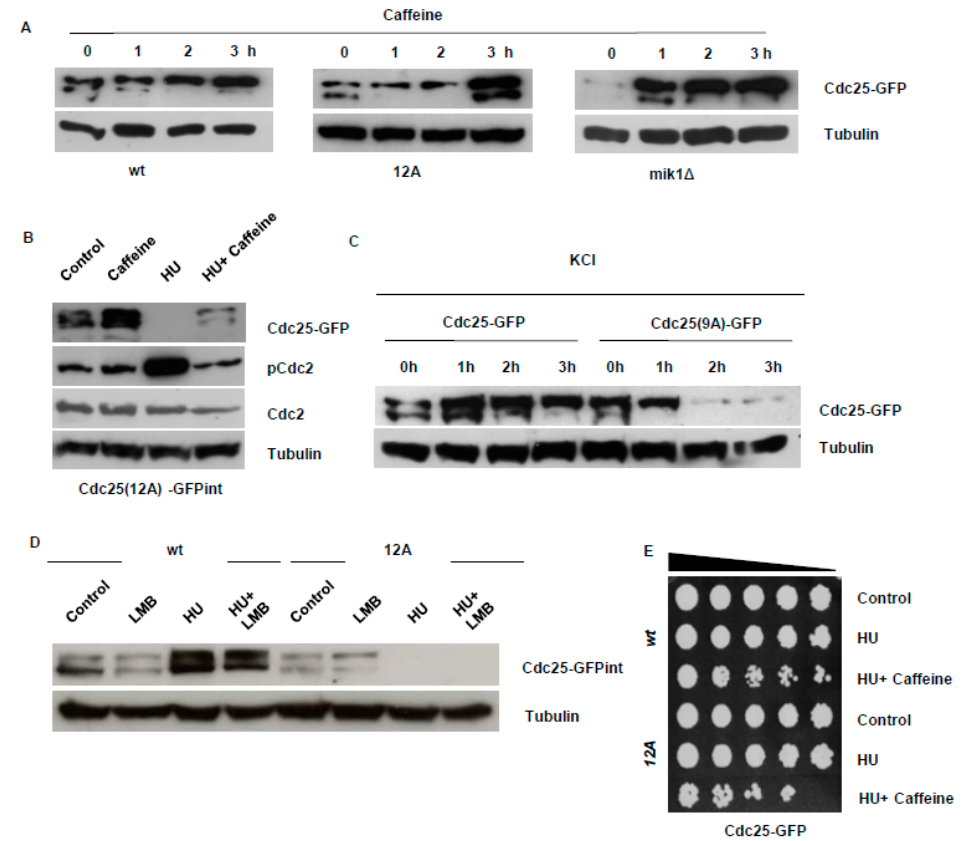
Figure 1. Ca ff eine induces the nuclear accumulation of Cdc25 in S. pombe . ( A ). Strains expressing wt Cdc25-GFP, Cdc25 (12A) -GFP, or Cdc25-GFP from a mik1 Δ genetic background were incubated with 10 mM ca ff eine and harvested at the indicated time points. Total protein lysates were resolved by SDS-PAGE and Cdc25 detected using antibodies directed against GFP. Gel loading was monitored using antibodies directed against tubulin. ( B ). Strains expressing Cdc25 (12A) -GFP int were pre-treated with 20 mM HU for two hours, followed by the addition of 10 mM ca ff eine. Cultures were incubated for a further 2 h and total protein lysates were resolved by SDS-PAGE. Cdc25 was detected using antibodies directed against GFP. Phospho-Cdc2 and Cdc2 were detected using antibodies directed against as indicated. Gel loading was monitored as in A. ( C ). Strains expressing wt Cdc25-GFP or Cdc25 (9A) -GFP were cultured in YES containing 0.6 M KCl and harvested at the indicated time points. Samples were analysed as in A. ( D ). Strains expressing wt Cdc25-GFP or Cdc25 (12A) -GFP int were incubated with 100 ng / mL LMB and 20 mM HU alone or in combination. Cells were pre-treated with HU for 2 h and then incubated with LMB for another 2 h as indicated. Samples were processed as in A. using antibodies directed against the HA epitope. Gel loading was monitored using antibodies directed against tubulin. ( E ). Strains expressing wt Cdc25-GFP and Cdc25 (12A) -GFP int exposed to 20 mM HU alone or further incubated with 10 mM ca ff eine as indicated. Samples were adjusted for relative cell numbers, serially diluted, plated on YES agar and incubated for 2–3